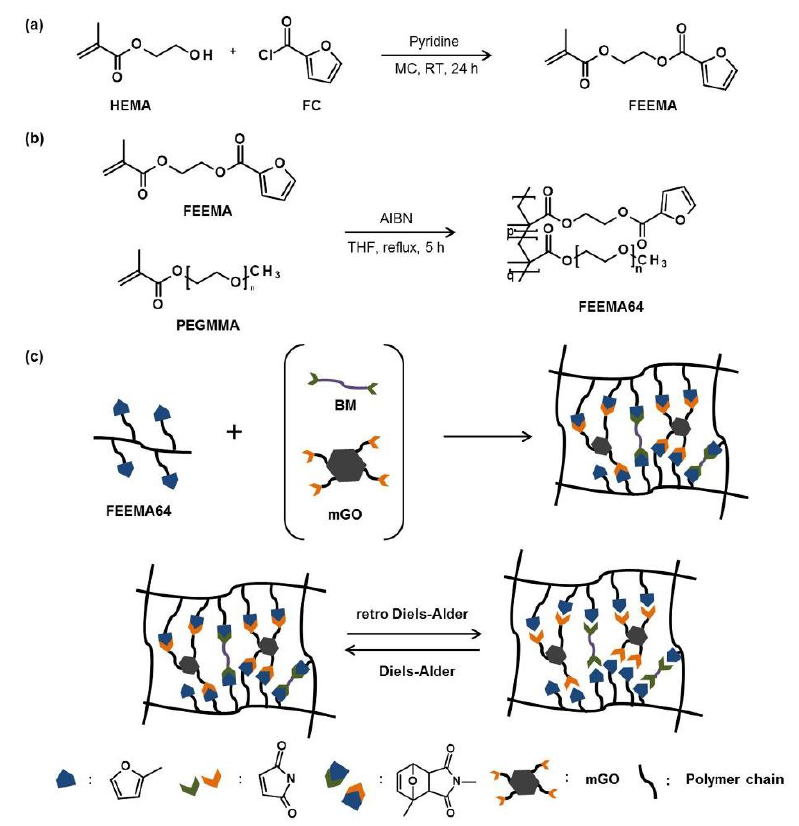
Table 1. Elemental analysis of FEEMA monomer.